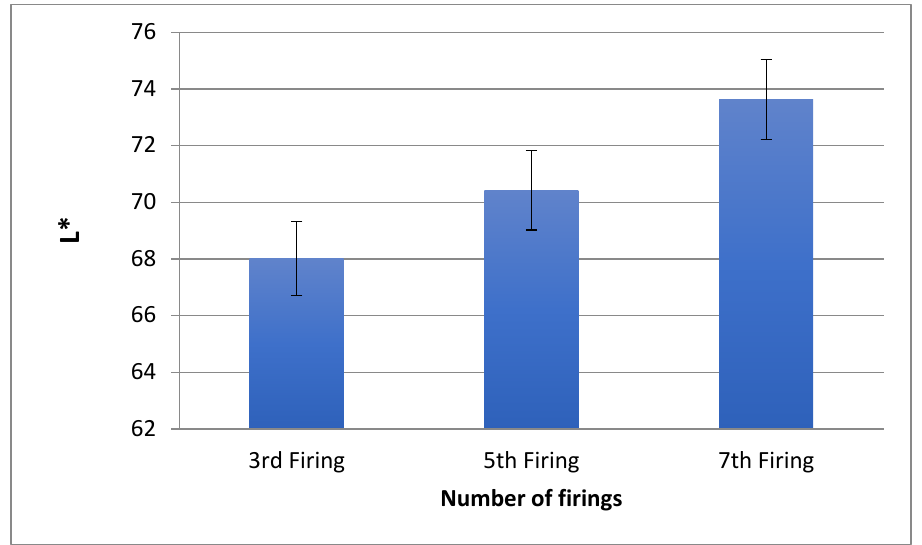
Figure 2. L* comparison of samples after the third, fifth, and seventh firings.